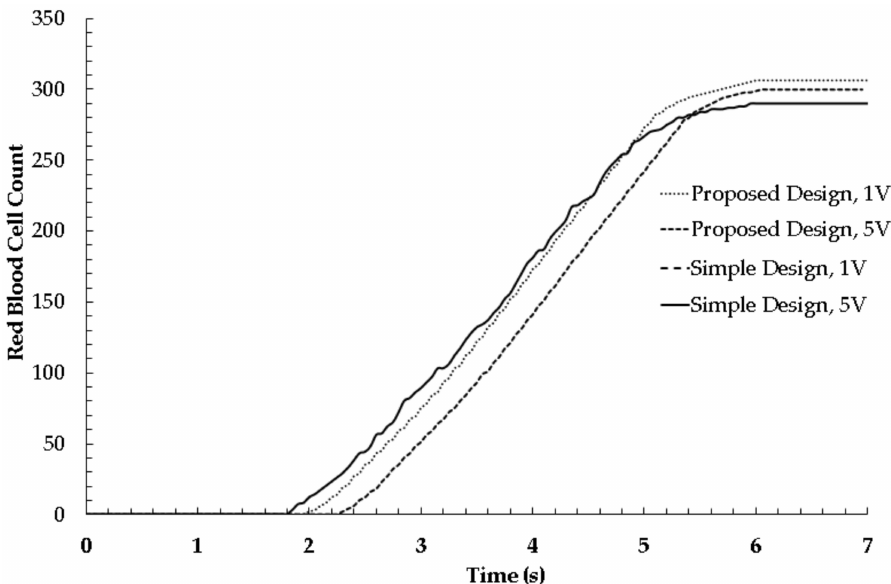
Figure 17. Plot of RBC cell count vs. time for varying input voltage for the proposed and simple square electrode design. Count measurements are taken in reference to the inlet and outlet.